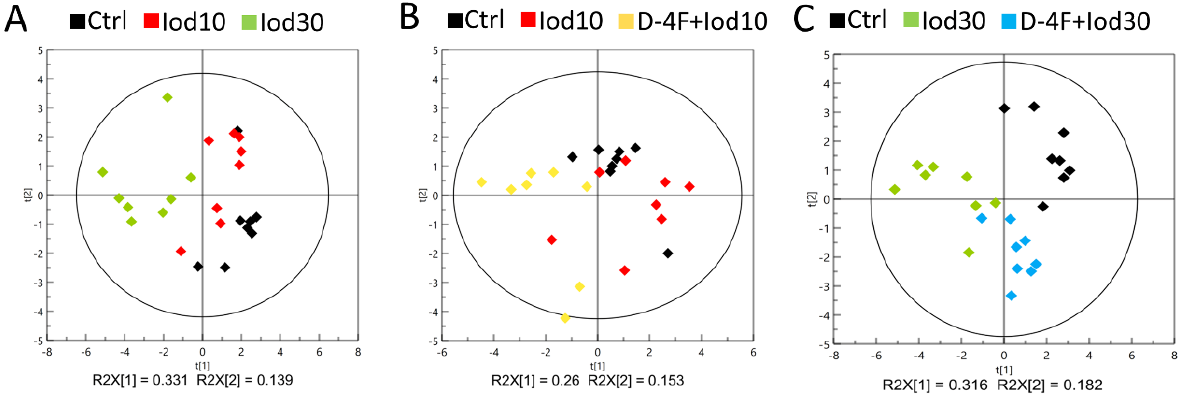
Figure 3. PCA scores plot for 1 H ‐ NMR spectra recorded on aqueous extracts of HUVECs. ( A ) The Ctrl, Iod10 and Iod30 groups; ( B ) the Ctrl, Iod10 and D ‐ 4F + Iod10 groups; and ( C ) the Ctrl, Iod30 and D ‐ 4F + Iod30 groups are shown.